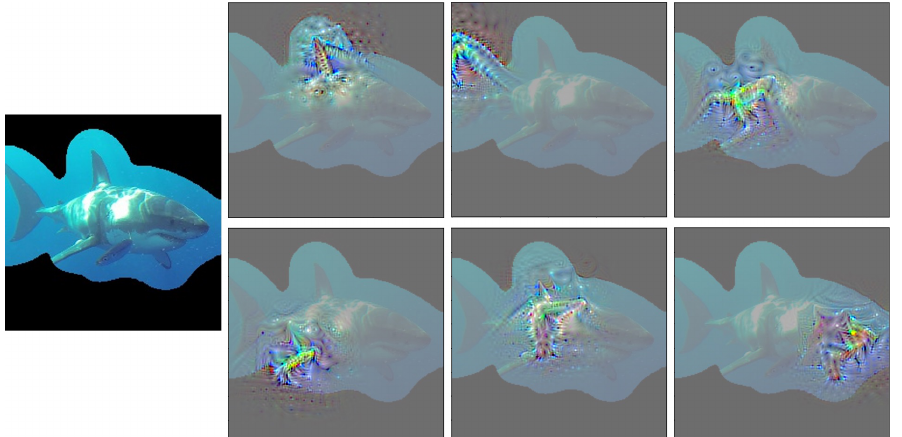
Figure 9. Visualization of the activation of neurons in conv2 layer in the block5 of VGG-16. The left most image is the input image, and the six other images are the results of optimization to maximize the activation of some neurons in the layer. The optimized images are slightly darker than the input image because they are re-scaled to visualize optimized regions